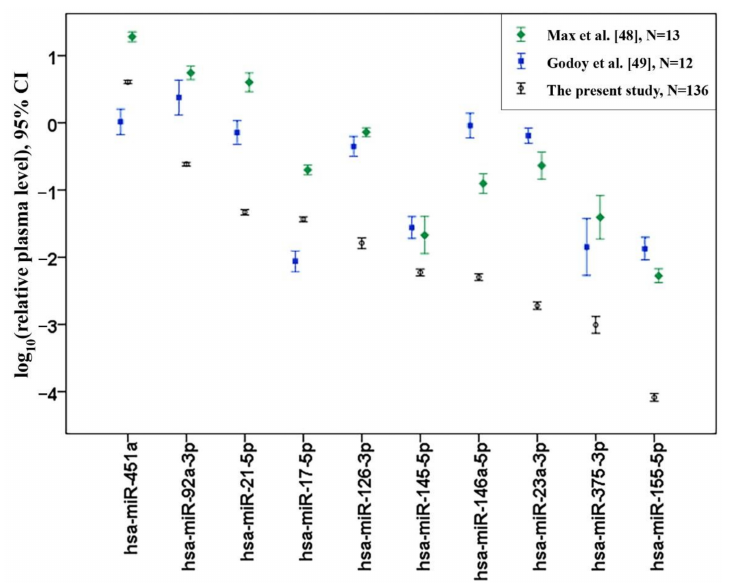
Figure 1. Comparison of miR-16-5p normalized relative plasma levels between the present study and the two most recent miRNA plasma sequencing studies performed on healthy adults. Error bars represent mean and 95% confidence interval (CI).